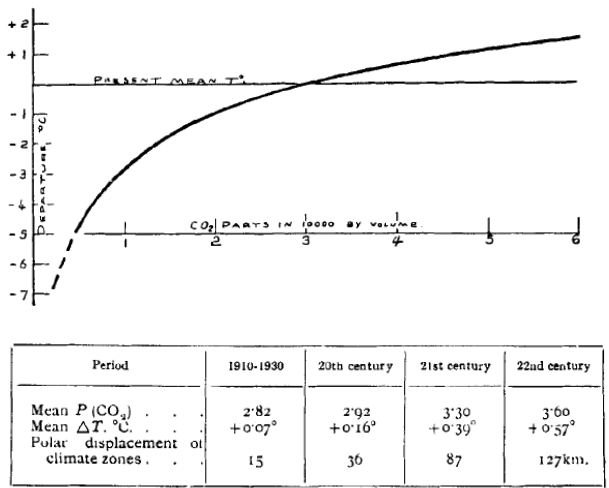
Fig. 3. From Callendar (1938). Armed only with a slide rule as a cal- culating machine, Callendar produced a very credible estimate (up- per panel) of the warming produced by a CO 2 doubling in the atmo- sphere. He assumed an ocean mixing time of 2000yr and viewed the ocean alkalinity as providing the key chemical capacity. But while Callendar had the robust physics of the radiation balance to rely on, his economic projections were less sound (lower panel). His esti- mate of atmospheric CO 2 levels in the 22nd century was reached by the end of the 20th century. He noted that alkalinity was not changed, but did not mention